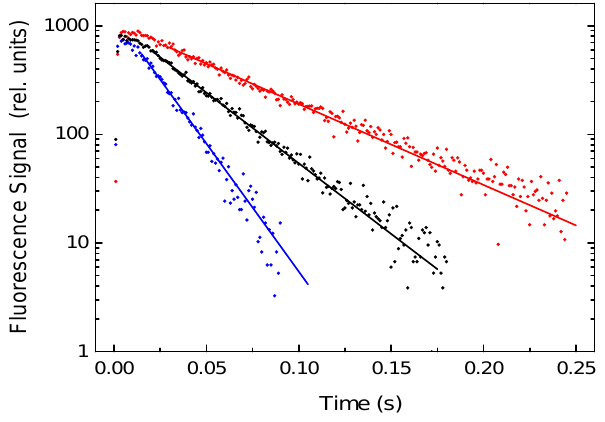
Fig. 2. OH decays measured in real-time by LP-LIF in differ- ent samples of air at the Backgarden field site in PRD on 11 July 2006. Dots denote the measured time-dependent fluorescence sig- nals recorded in time bins of 1ms width, after an off-resonance background signal (ca. 1 - 2rel.units) has been subtracted. The solid lines are exponential fits to the decay curves, yielding OH re- activities as reciprocal 1/e liftetimes (red line 17 s − 1 ; black line 30 s − 1 ; blue line 54 s − 1 ). The decay rate coefficients include the con- tribution of OH wall loss (1.4s − 1 ) in the flow tube, which needs to be subtracted to obtain atmospheric OH